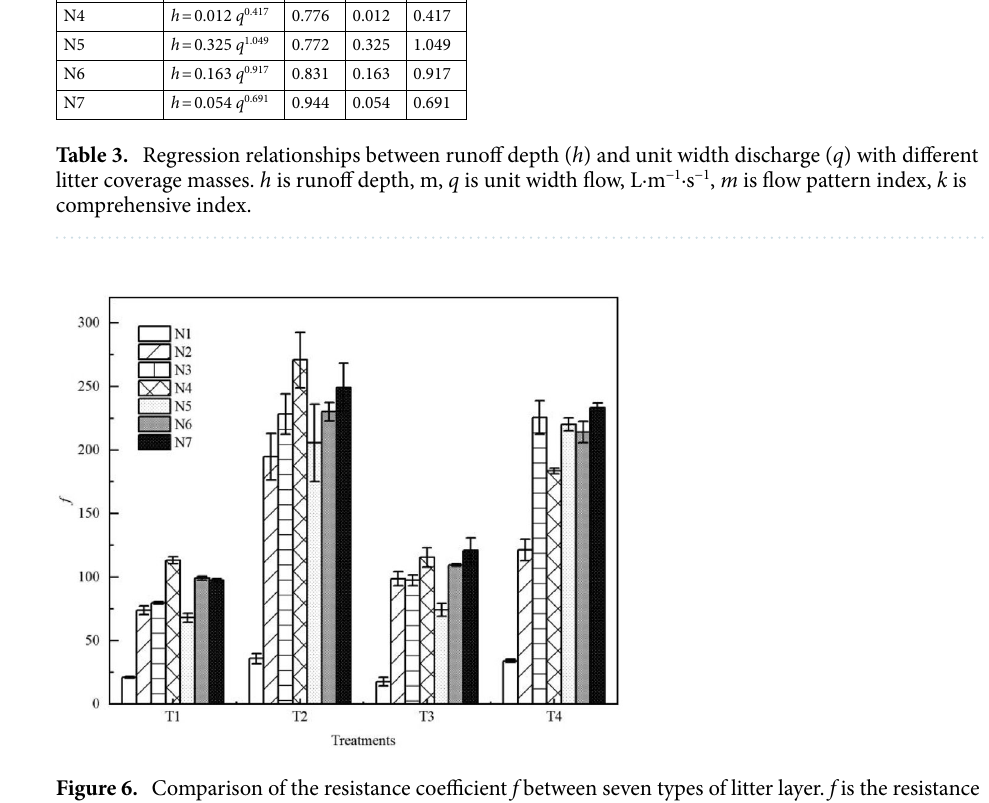
Figure 6. Comparison of the resistance coefficient f between seven types of litter layer. f is the resistance coefficient; N1–N7 are treatments, see Table 2 for treatment specifics; T1 is slope 5°, rain intensity 60 mm·h −1 ; T2 is slope 10°, rain intensity 60 mm·h −1 ; T3 is slope 5°, rain intensity 120 mm·h −1 ; T4 is slope 10°, rain intensity 120 mm·h −1 . Error bars indicate standard